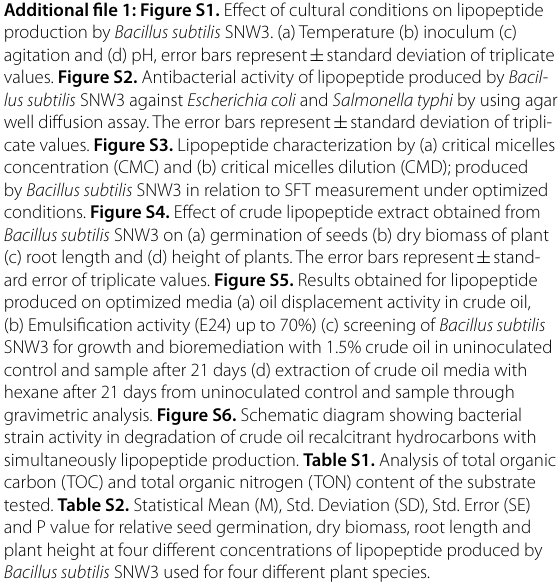
Bacillus subtilis SNW3 used for four different plant